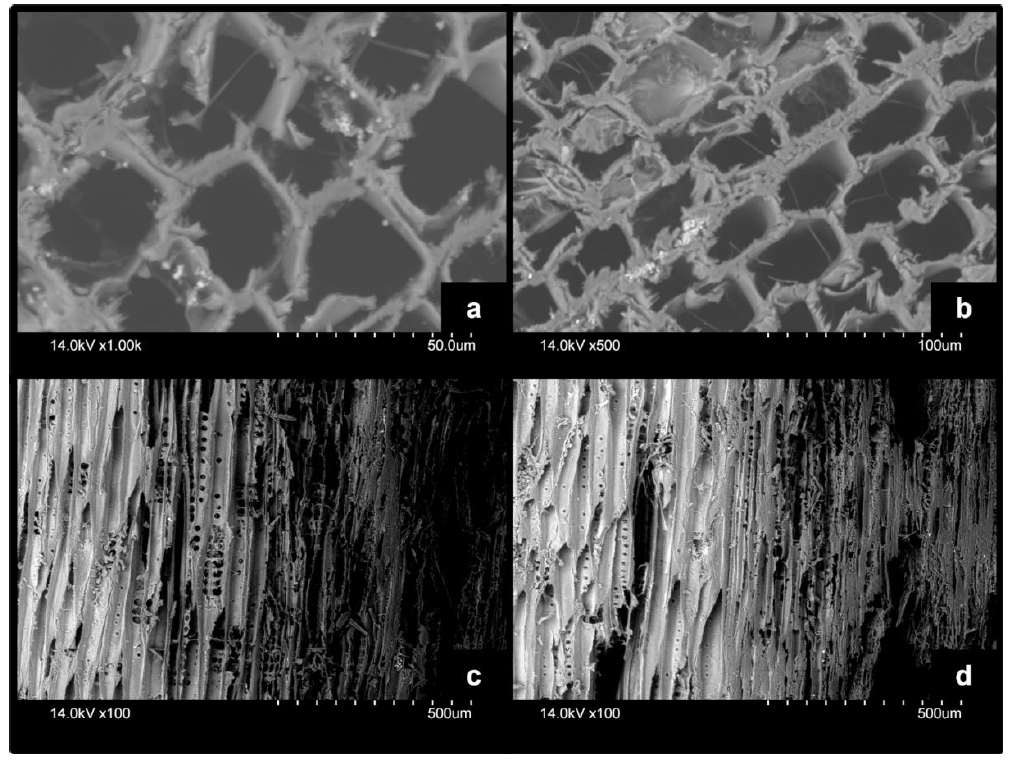
Figure 8. SEM pictures of cross section (above) and longitudinal section (below) of decayed Scots pine wood: ( a ) thinned cell wall structure, ( b ) fungal hyphae in lumina, ( c ) fibrous structure, ( d ) gradual disappearance of bordered pits on decay border.